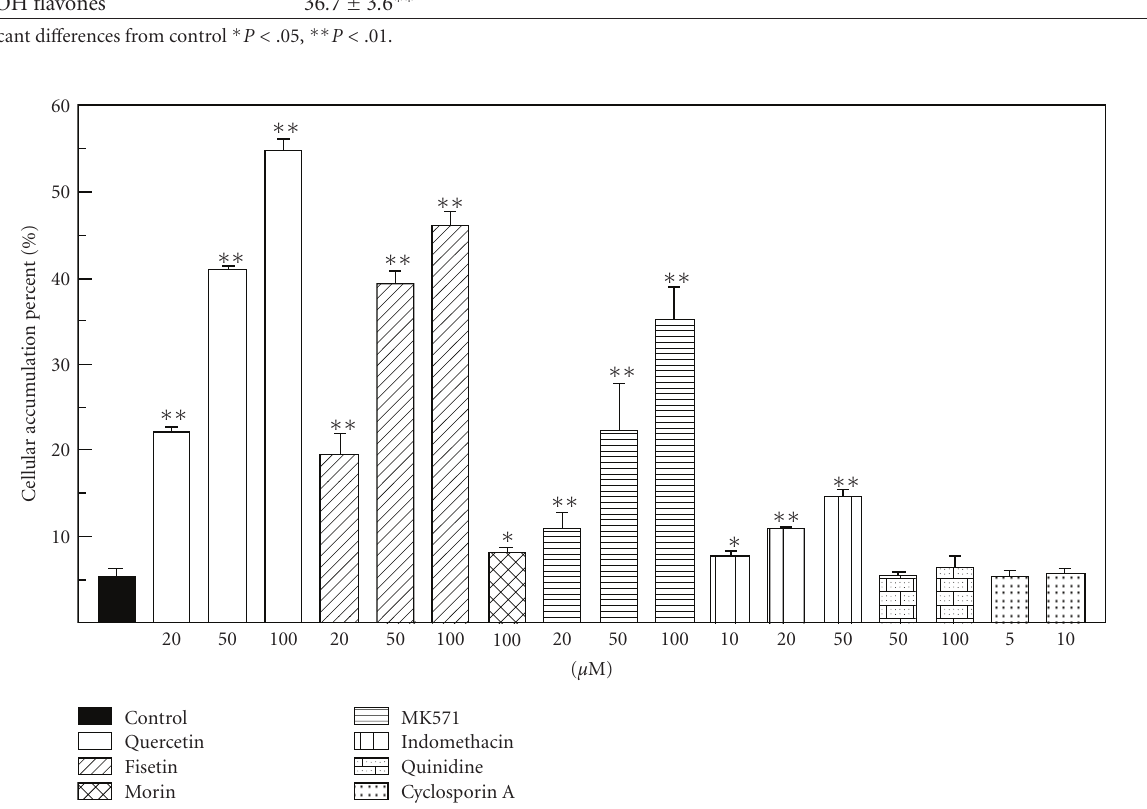
Figure 4: The e ff ect of flavonols and transpoter inhibitors on the cellular accumulation of N -acetyl 5-aminosalicylic acid in Caco-2 cells. Caco-2 cells grown in tissue culture dishes were incubated with 200 μ M 5-ASA for 2 hours in the presence of flavonols and transporter inhibitors at the concentration of 100 μ M. Cellular accumulation percent : (cells/cells plus medium) × 100. Each bar represents the mean ± SD of four to five experiments. Significant di ff erence from control ∗ P < . 05, ∗∗ P < .